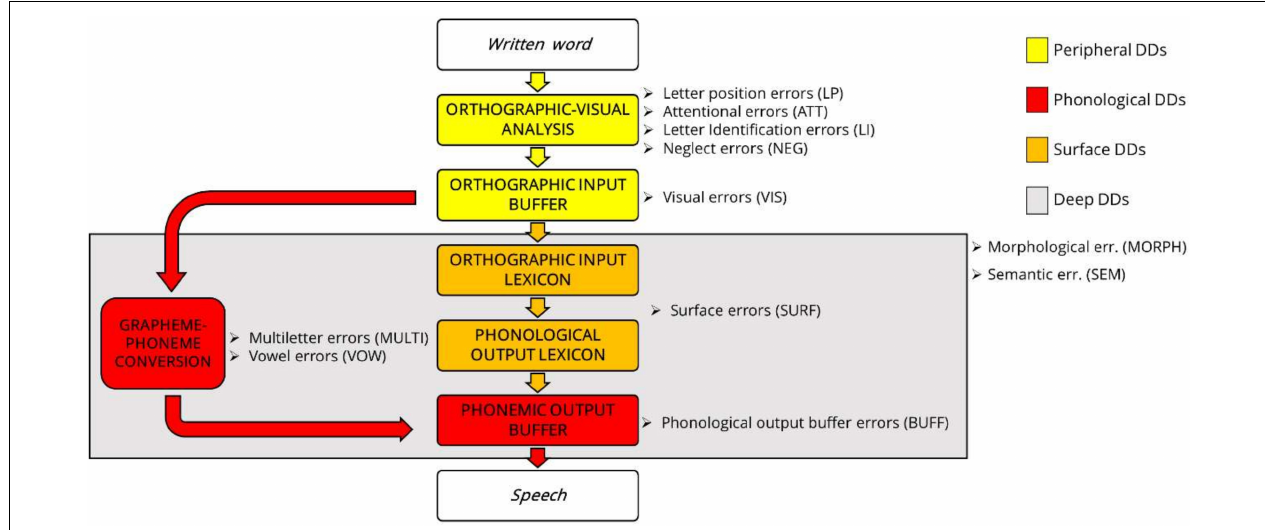
FIGURE 1 | Dual-route model of reading aloud, with different error types associated with each section of the model, and consequential types of DD. Yellow cases display the visual-orthographic step of reading; orange cases display the lexical route; and red cases display the sublexical route of reading, including the phonological output buffer (Casani, 2021, adapted after Friedmann and Coltheart,